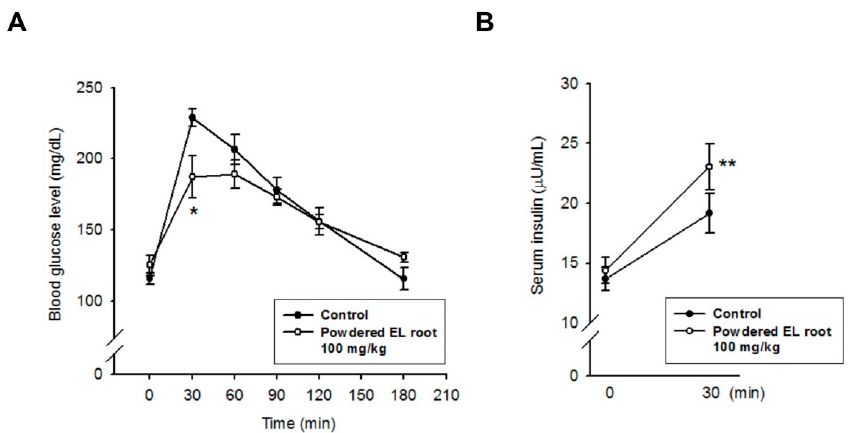
Figure 3. The E. longifolia -mediated improvement in glucose tolerance, which coincided with an increase in glucose-stimulated insulin secretion. After administration of powdered EL root for 2 weeks, the C57BL / 6J mice were subjected to an OGTT. ( A ) Following the glucose challenge, the EL-treated mice had a lower glycemic peak and a lower area under the curve than the control mice. ( B ) Sera samples were collected at 30 min after the glucose bolus, and the plasma insulin concentration was quantified as described. EL treatment improved glucose-stimulated insulin secretion. (* p < 0.05, ** p < 0.01, indicates a statistically significant di ff erence from the control group).